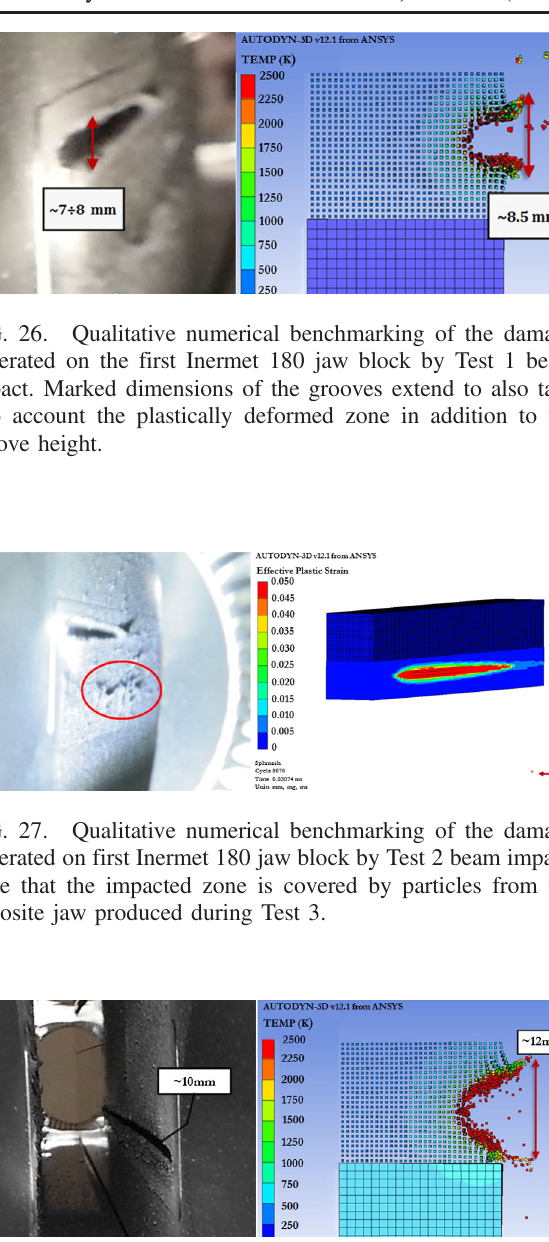
FIG. 28. Qualitative numerical benchmarking of the damage generated on the first Inermet 180 jaw block by Test 3 beam impact. Marked dimensions of the grooves extend to also take into account the plastically deformed zone in addition to the groove